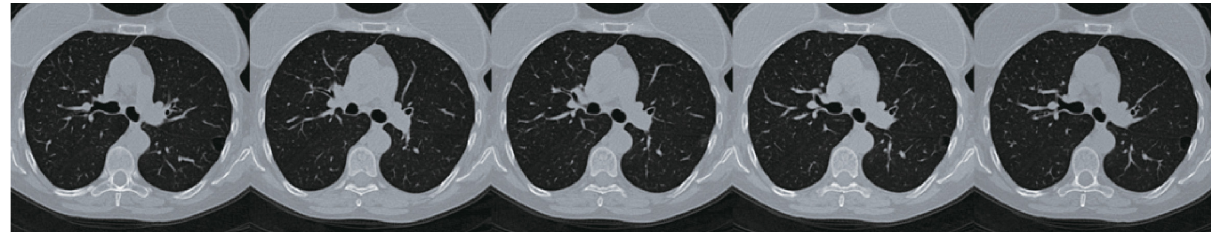
Fig 1. An example of a lung CIS with 5 neighboring CI